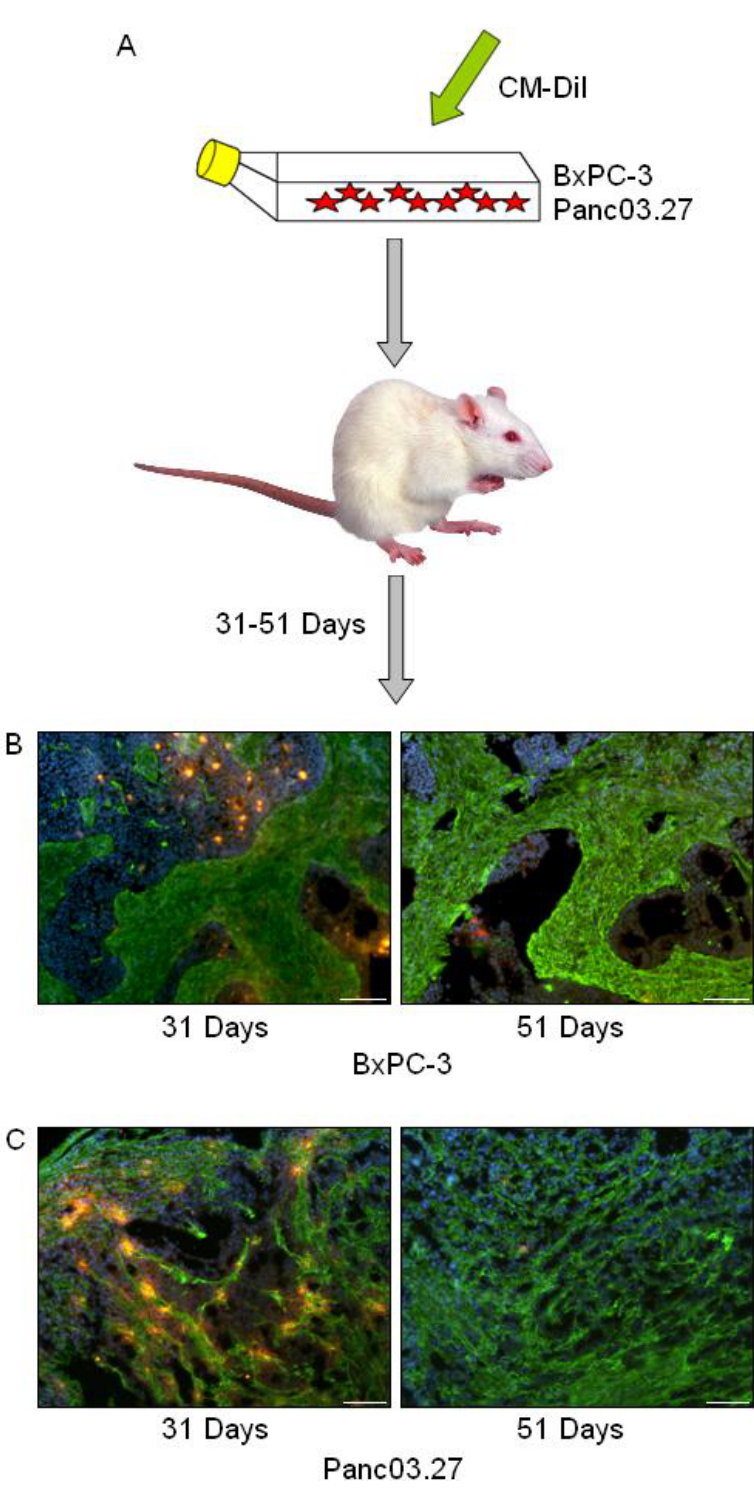
Figure 1. In vivo DiI+/SCC Selection. ( A ) Schematic diagram: BxPC-3 or Panc03.27 cells were labeled with CM-DiI and subcutaneous tumors were established in CB17/SCID mice. Tumors were harvested after 31 or 51 days and processed for immunohistochemical analysis. ( B ) BxPC-3 and ( C ) Panc03.27 tumor sections from 31 or 51 day tumors displaying a reduction in DiI+ cells (red) over time. Slides are additionally stained against fibroblasts (Alexa Fluor 488, green) to show stromal networks and counterstained with Dapi (blue). Bars represent 100